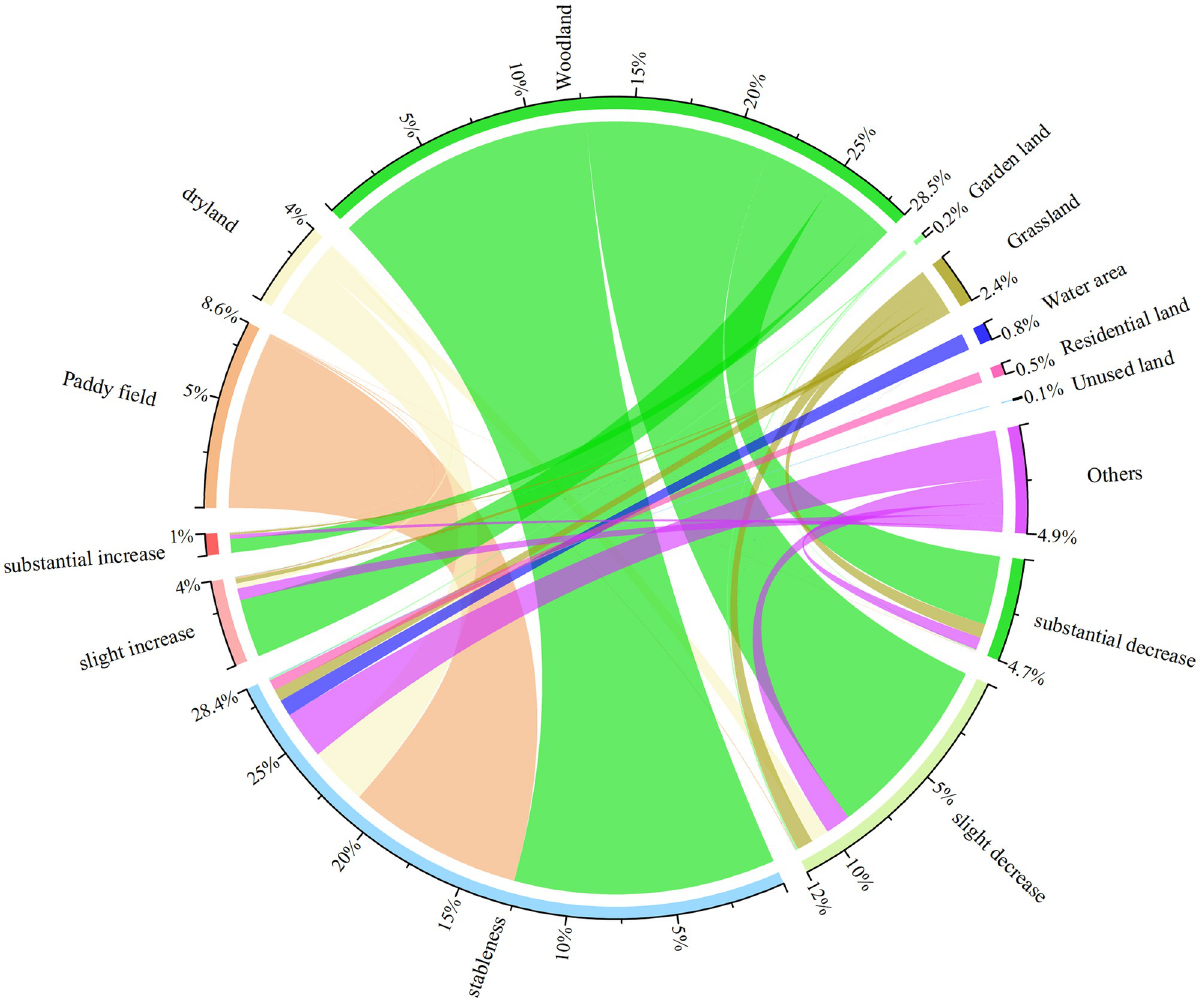
Fig 6. Statistics of the changes in the soil erosion based on different land use types in the study area from 2000 to 2018.